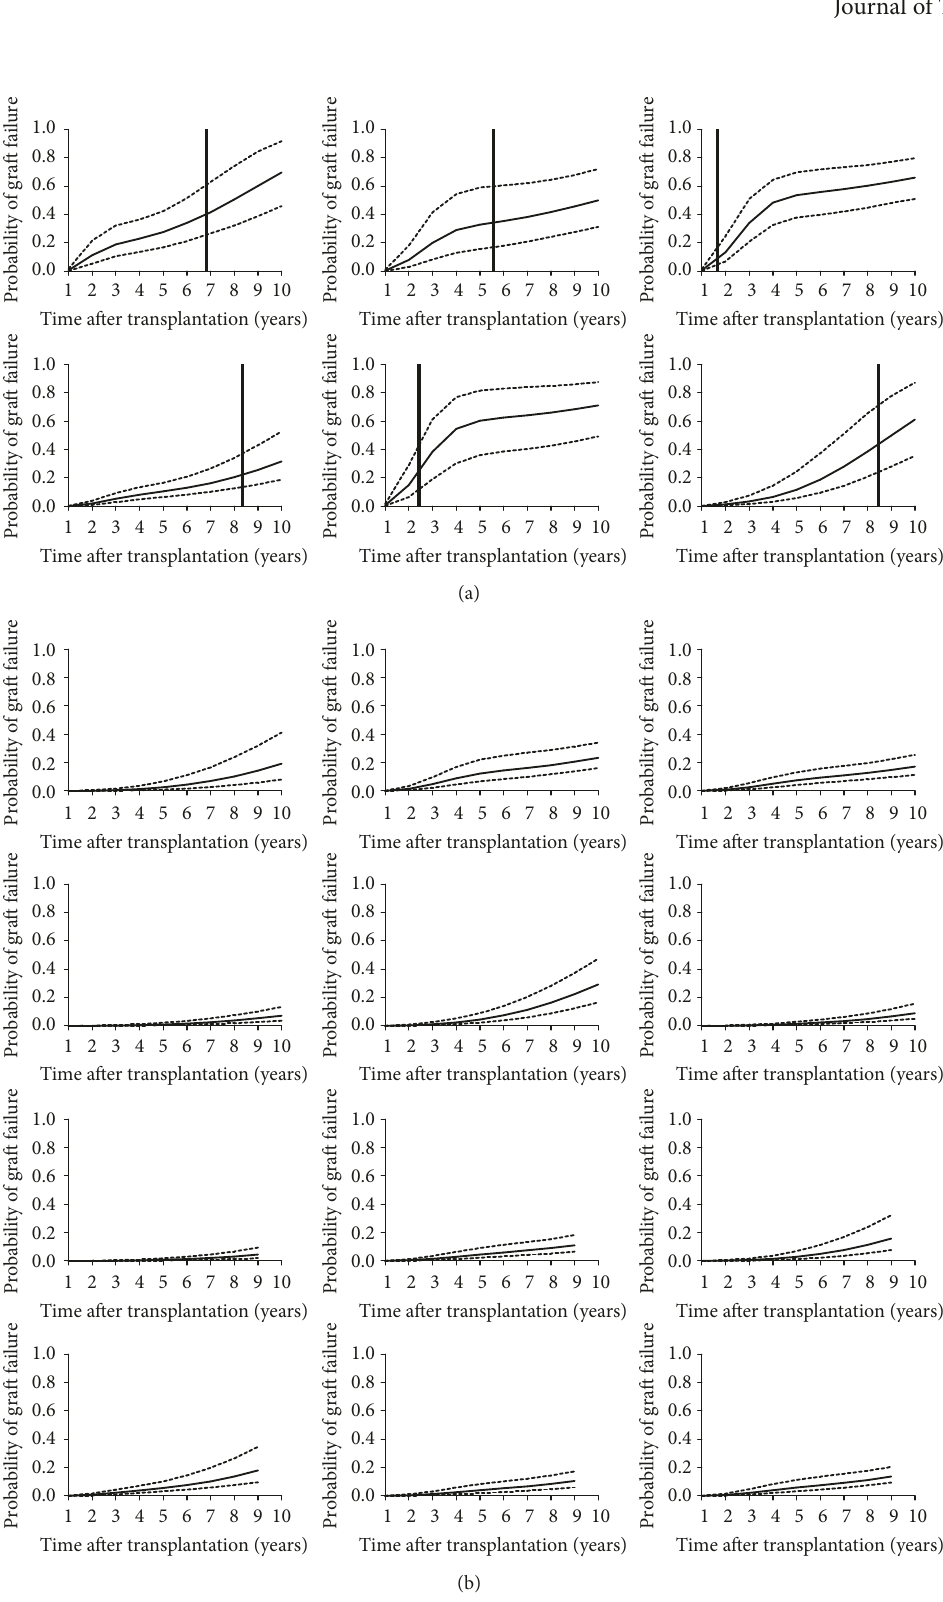
Figure 3: Individual predictions of 10-year graft failure risk based on covariates known at 1 year after transplantation for 18 patients without dn DSA (a) who experienced graft failure and (b) who did not experience graft failure. Solid lines indicate the predicted medians and dashed lines indicate the 95% confidence intervals; the vertical line indicates time of graft